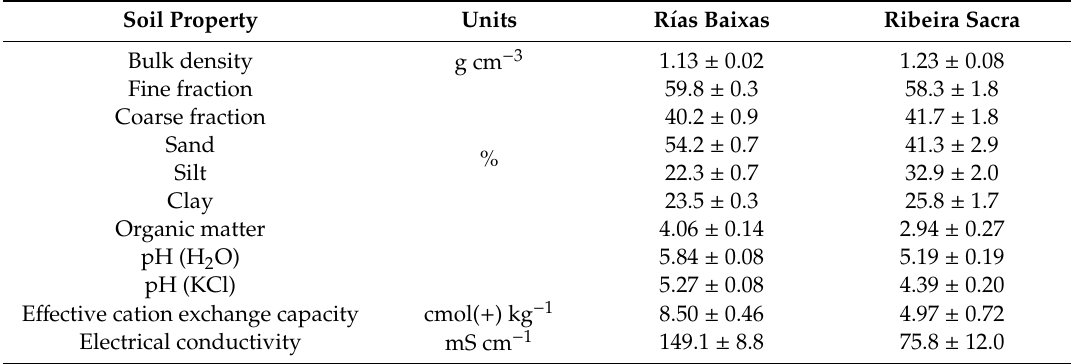
Table 1. Main physical and chemical properties from the surface layer of the soils from the two experimental vineyards studied (averages ± standard